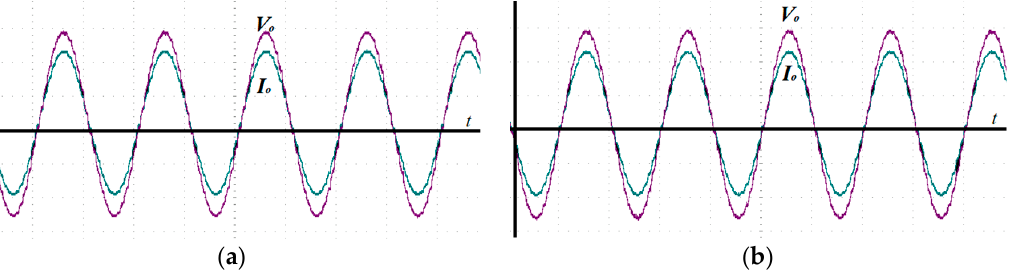
Figure 14. Dynamic response when the output reference current is sinusoidal, V o (10 V/div), I o (1 A/div). ( a ) traditional PCC; ( b ) SMPCC.